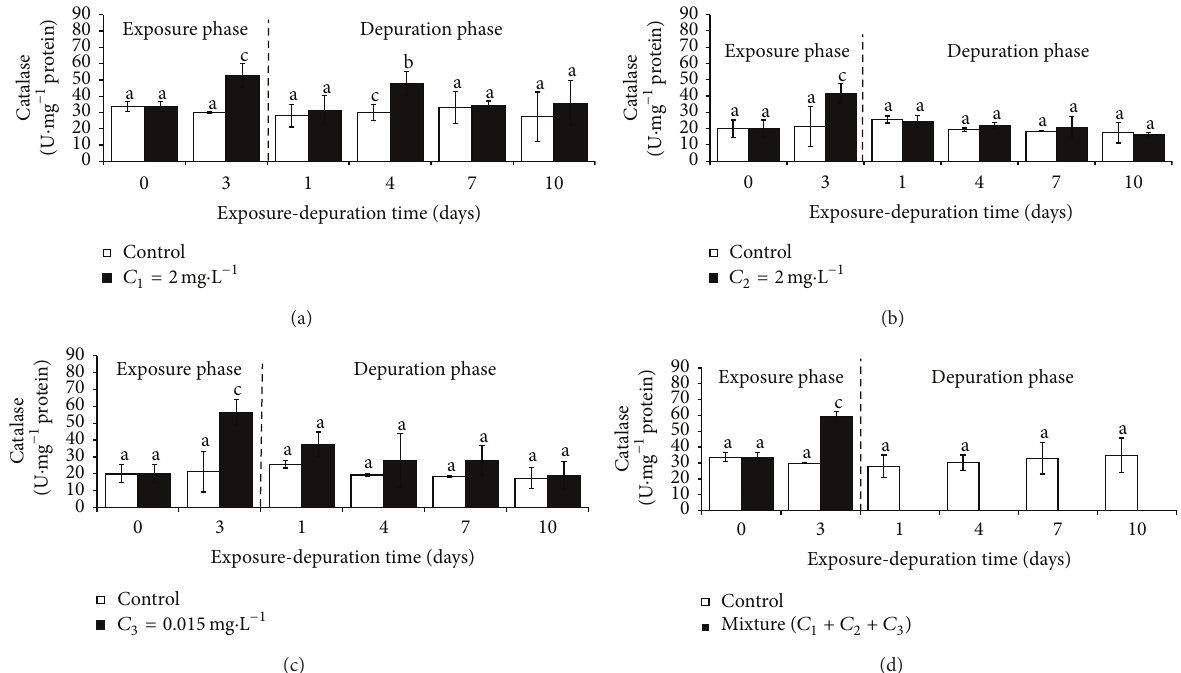
Figure 3: Mean ( ± SD) variation of catalase activity in Perna perna of control and Cd- (a), Pb- (b), Cu- (c), and mixture-exposed mussels (d) during 3 days of exposure and 10 days of depuration. Values followed by the same latter are not statistically different ( 𝑃 > 0.05 ) but Values followed by the different latter are statistically significant ( 𝑃 < 0.05 ).